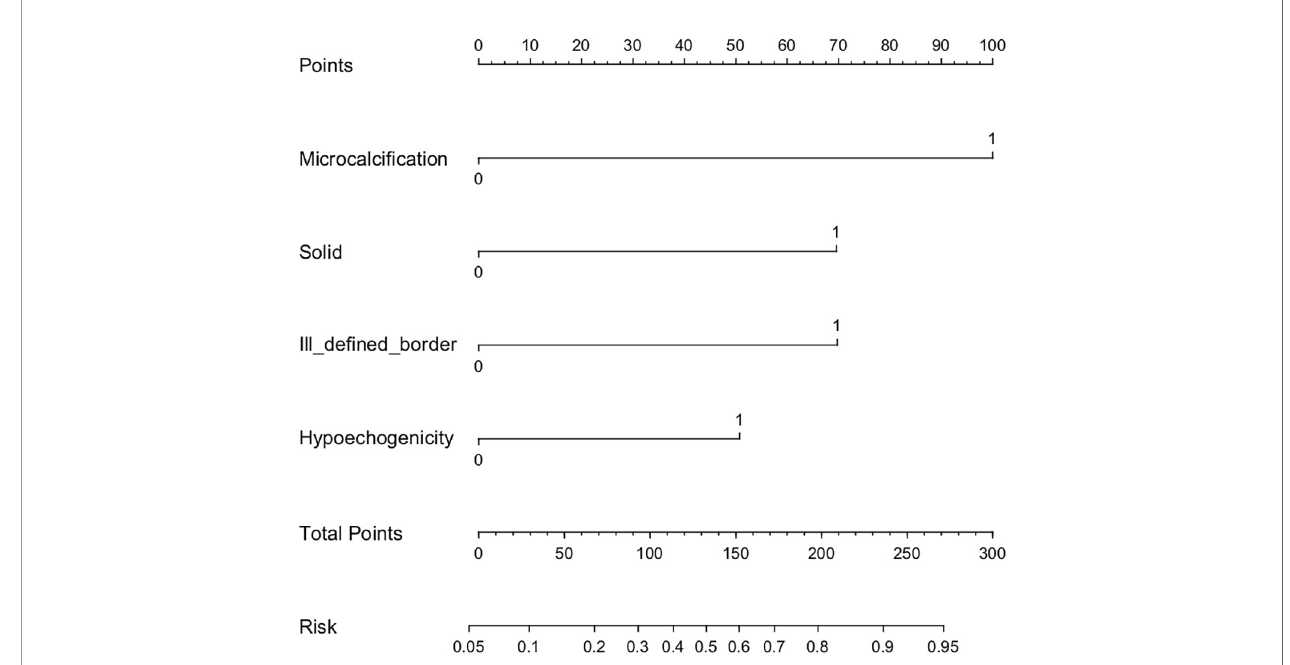
FIGURE 2 | Risk strati fi cation nomogram to predict the probability of malignancy of thyroid nodules > 4 cm. For example, a solid hypoechogenic thyroid nodule > 4 cm that shows the ultrasound feature of microcalci fi cation, but not ill-de fi ned border receives 221 points and a malignancy risk of 0.88 (high